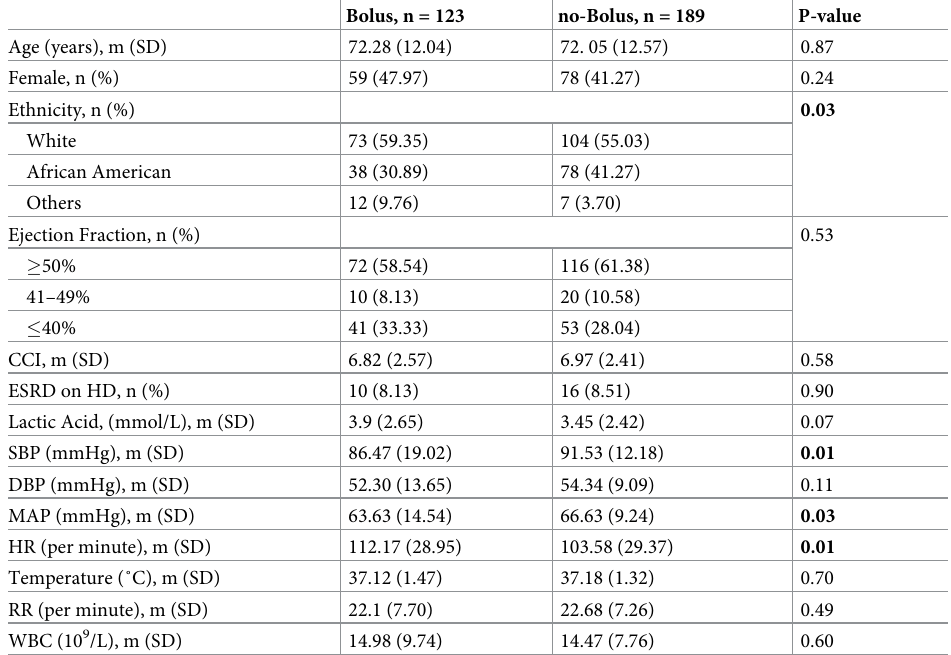
m = mean; n = number; SD = Standard Deviation; CCI = Charlson-Comorbidity Index; ESRD on HD = End-Stage Renal Disease on Hemodialysis; SBP = Systolic Blood Pressure; DBP = Diastolic Blood Pressure; MAP = Mean Arterial Pressure; HR = Heart Rate; RR = Respiratory Rate; WBC = White Blood Cell. Significant P-values are in